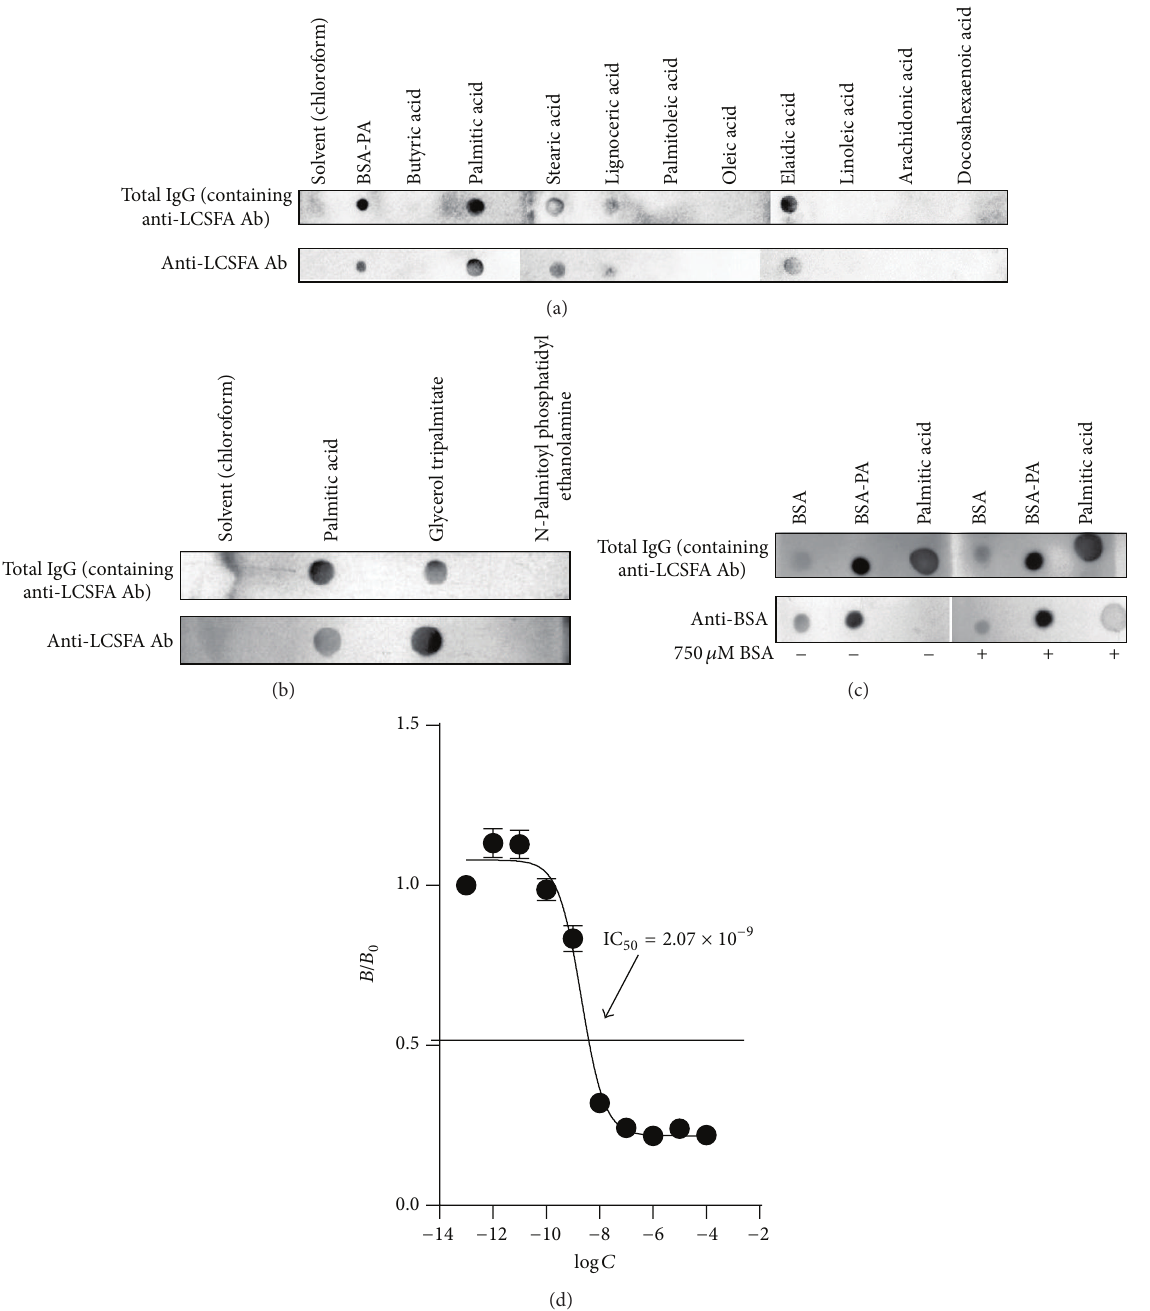
Figure 4: Specificity of diabetic patient anti-LCSFA IgG antibodies for long chain saturated FAs. (a) Lipid dot blot of a panel of nonesterified FAs. Dot blots presented are from one patient serum and are representative of dot blots performed with antibodies isolated from the sera of 5 diabetic patients. The FAs were probed with purified total IgG or purified anti-LCSFA IgG isolated from the same individual. Anti-human IgG conjugated to alkaline phosphatase was used as the secondary Ab. The blots are representative of separate experiments performed with Abs isolated from the sera of 1 of 5 En Balance participants positive for anti-LCSFA IgG. (b) Lipid dot blot comparison of nonesterified and esterified palmitic acid. The palmitic acid molecules were probed with purified IgG or purified anti-LCSFA IgG as the primaryAb.Anti-humanIgGconjugatedtoalkalinephosphatasewasthesecondaryAb.Thedotblotsshowanexperimentfromoneindividual representative of 3 experiments performed with Abs isolated from 3 En Balance participants. (c) Dot blot binding assay from a representative patient demonstrating anti-LCSFA binding palmitic acid in the presence of physiological levels of BSA (750 𝜇 M). (d) Competition ELISA determination of anti-LCSFA IgG avidity. log 𝐶 is the log 10 of the concentration of the competitor BSA-PA in mol/L. The ratio between the absorbance with competition (𝐵) and without competition (𝐵 0 ) is plotted. Each data point represents the mean ratio of the absorbance ± SEM of antibodies from 5 participant